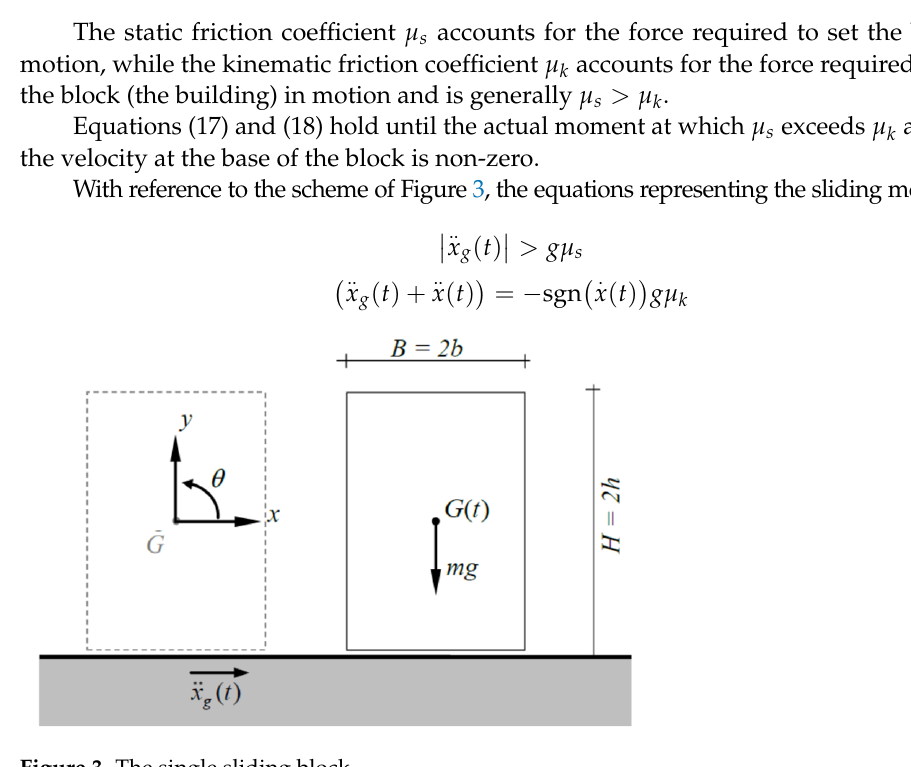
Figure 3. The single sliding block.